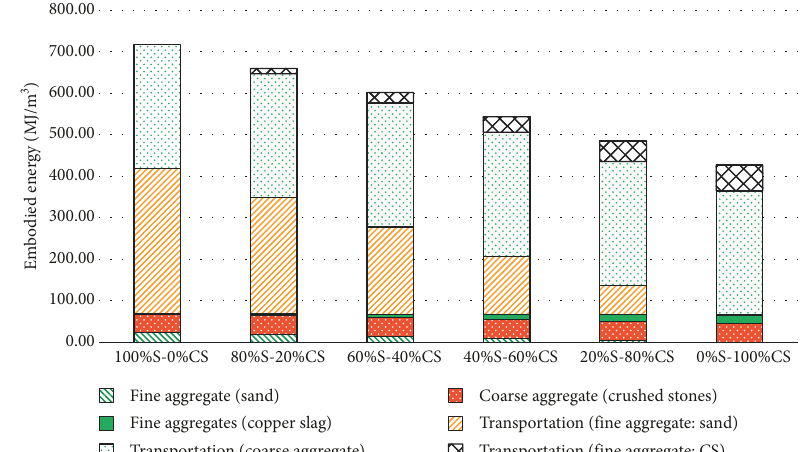
Figure 4: Distribution of embodied energy results for concrete aggregates (cement impacts are excluded), GreenConcrete LCA tool [3].